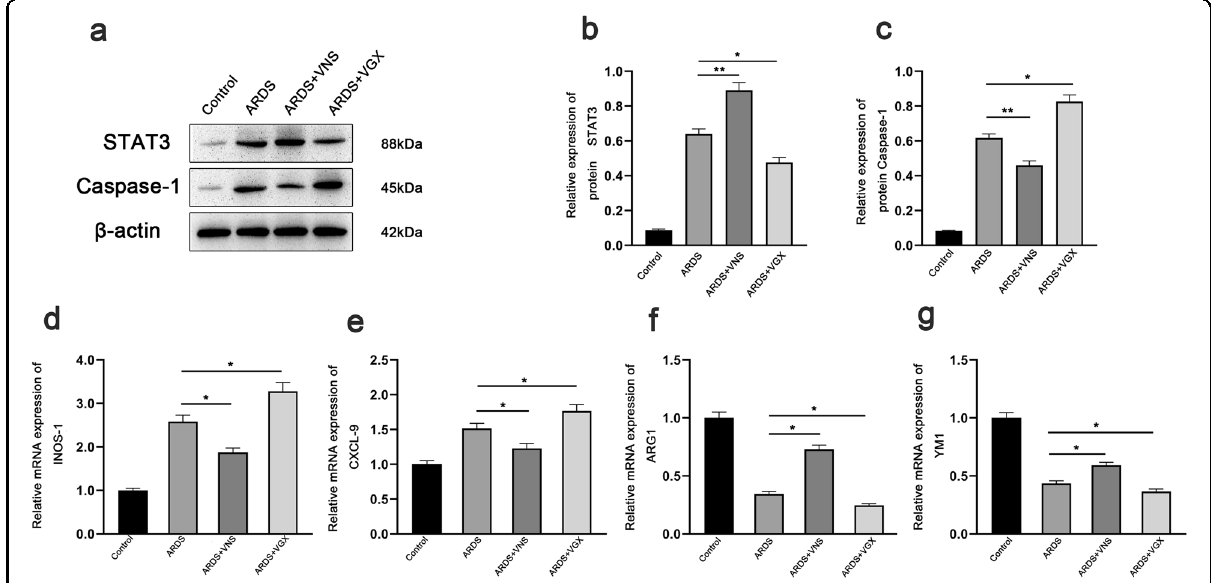
Fig. 2 Effects of VNS on STAT3, Caspase-1, and M1M2 macrophage phenotype. a Representative western blotting images of STAT3 and Caspase-1 expression in ARDS group, ARDS + VNS group, and ARDS + VGX group ( n = 6 biological replicates). b , c Comparison of mean intensity ratios for STAT3 and Caspase-1 in the ARDS group, ARDS + VNS group, and ARDS + VGX group ( n = 6 biological replicates) through western blotting analysis. d – g The mRNA levels of the M1 macrophage markers, iNOS and CXCL-9, and those of the M2 macrophage markers, Arg1 and Ym1, were measured in the ARDS group, ARDS + VNS group, and ARDS + VGX group by qPCR and normalized to GAPDH mRNA levels ( n = 6 biological replicates). The results are expressed as the mean ± SEM ( n = 6 biological replicates); * p < 0.05,** p <